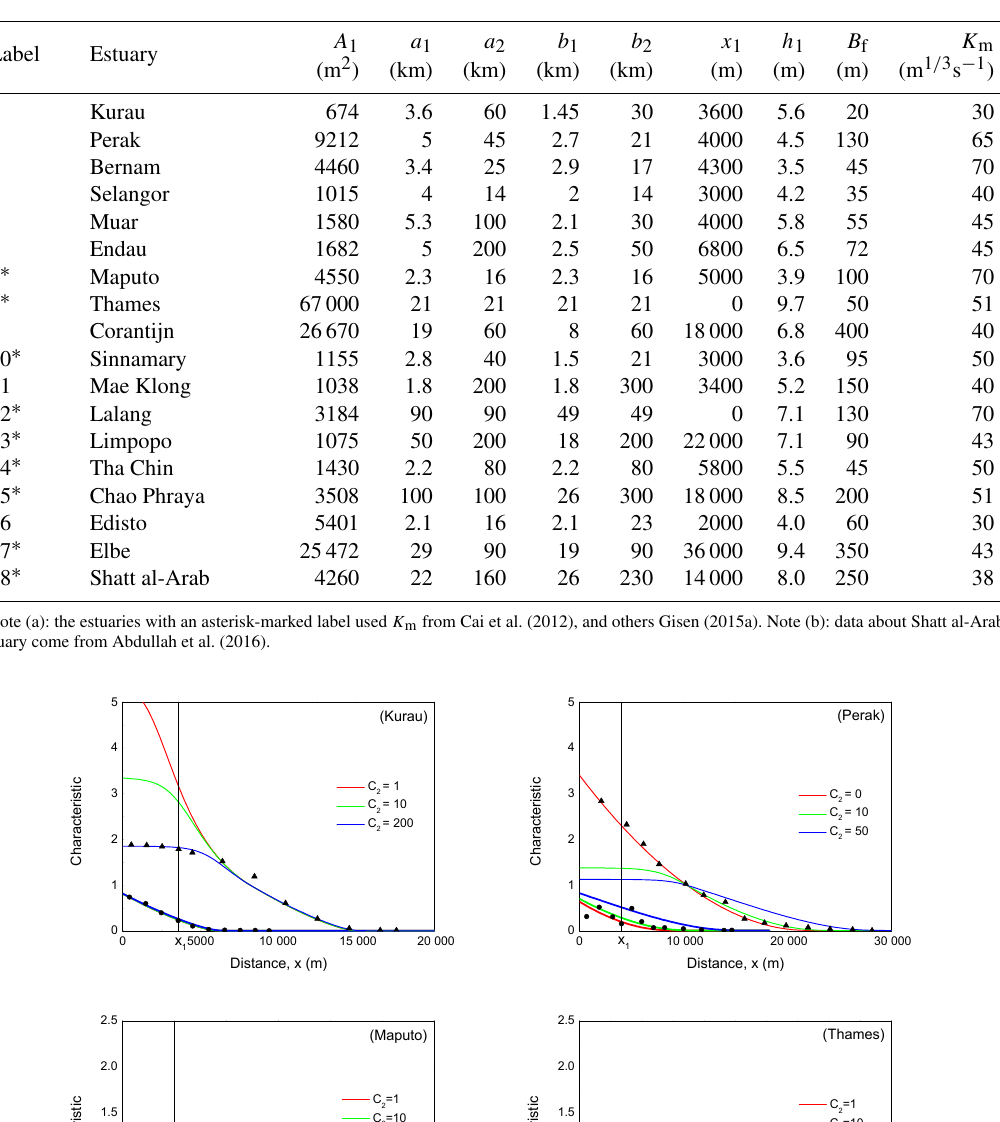
Table 1. Summary of the geometry of the estuaries.